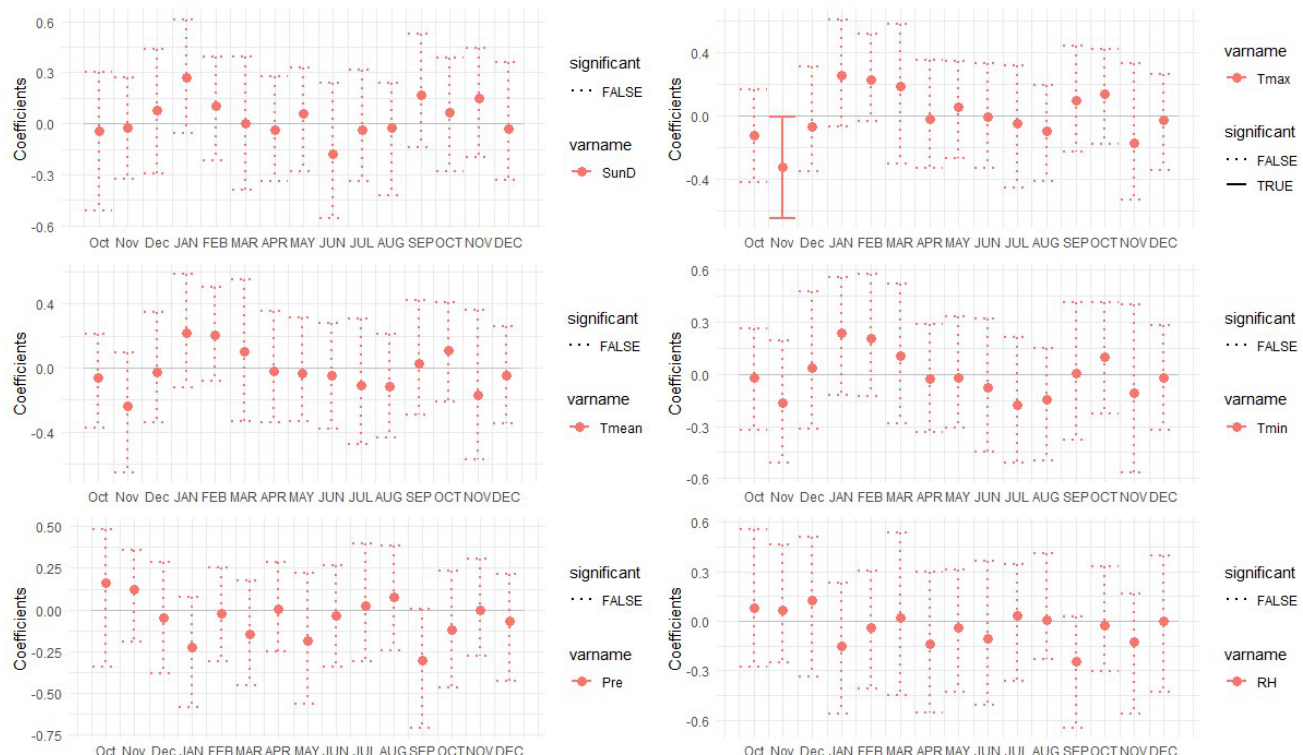
Figure A5. Correlation coefficient between TRW and climate during 1955–1985.